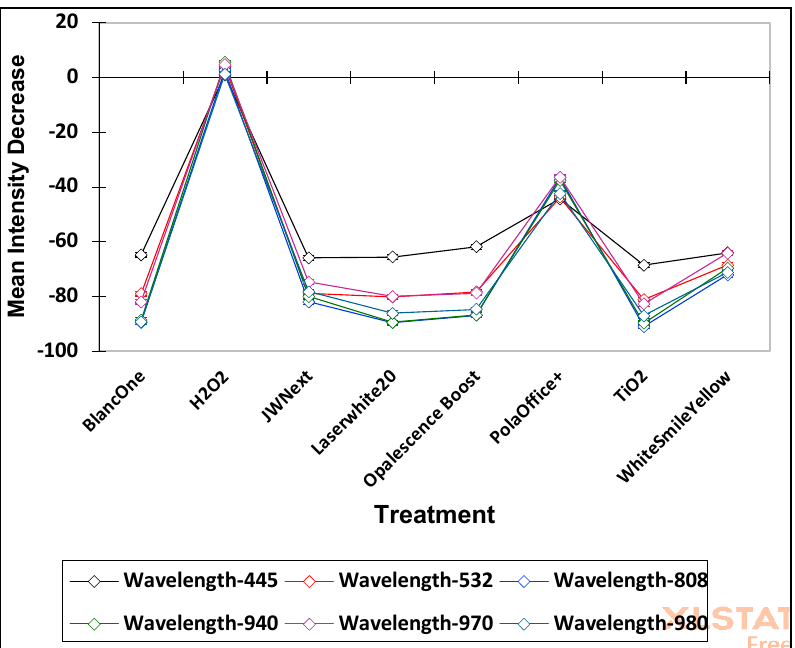
Figure 4. Plots of mean intensity decrease responses from each of the 7 products and H 2 O 2 control treatments evaluated at wavelengths of 445, 532, 808, 940, 970 and 980 nm.